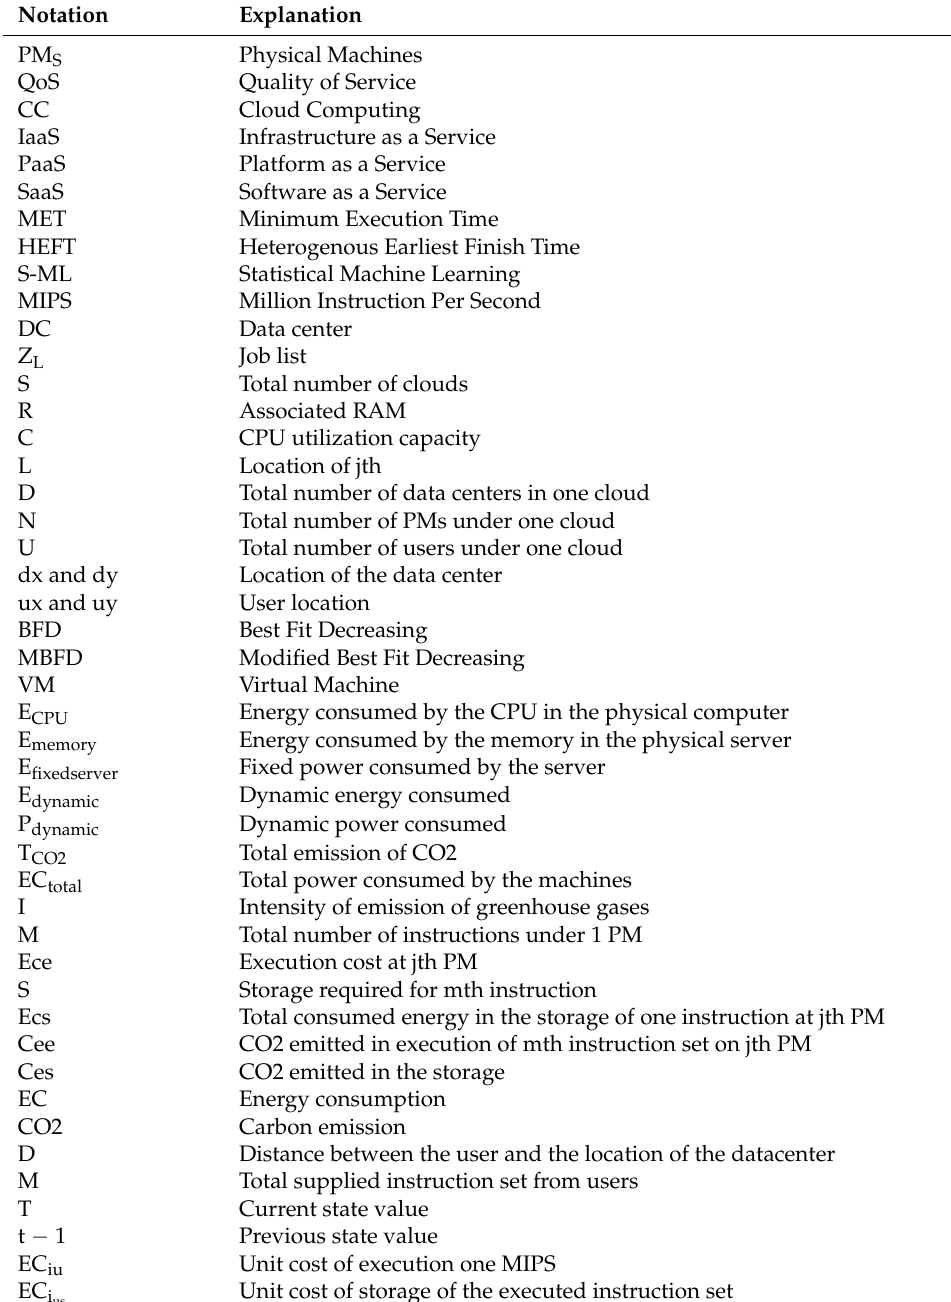
Table 1. Important Notations and